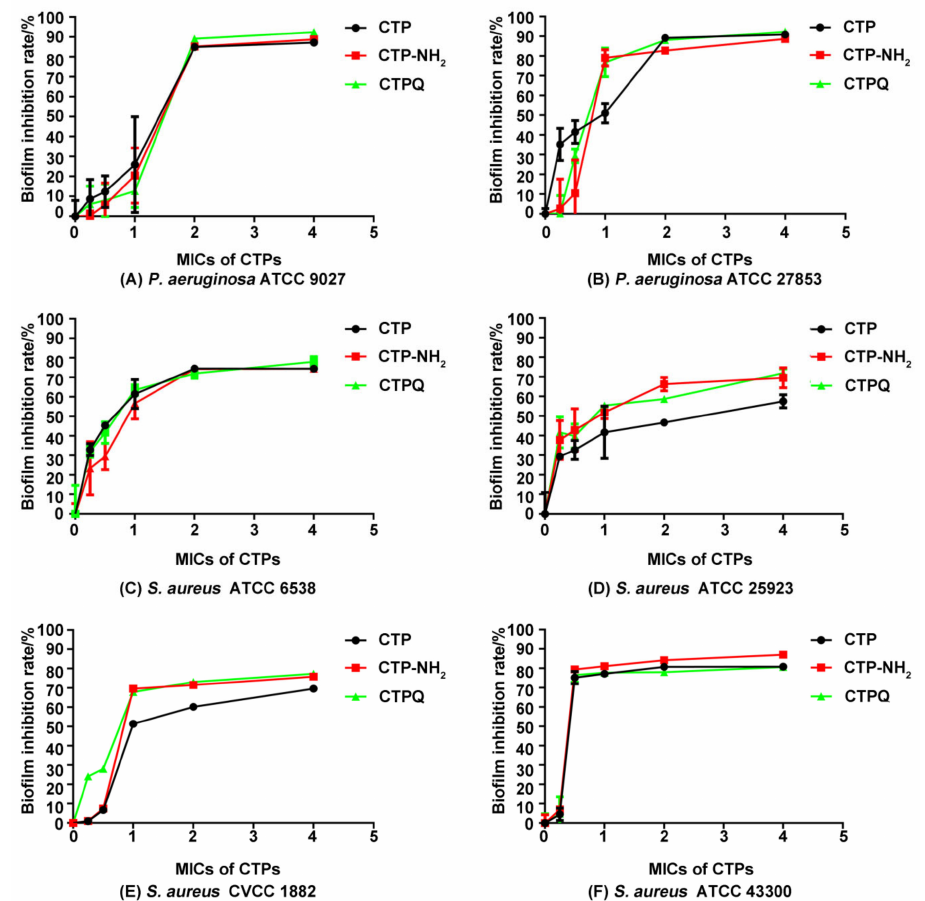
Figure 9. Antibiofilm activity of CTPs (CTP, CTP-NH2, and CTPQ) against ( A ) P. aeruginosa ATCC 9027, ( B ) P. aeruginosa ATCC 27853, ( C ) S. aureus ATCC 6538, ( D ) S. aureus ATCC 25923, ( E ) S. aureus CVCC 1882, and ( F ) S. aureus ATCC